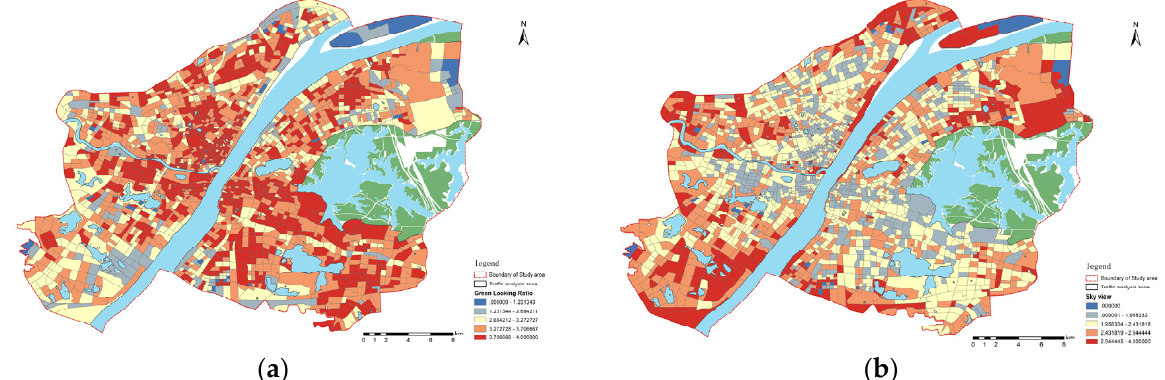
Figure 13. Block environment perception. ( a ) Green-looking ratio; ( b ) sky view. From the color distribution of the two graphs, it is clear that a block with a high green-looking ratio has a lower sky view, which aligns with the general perception. A high green-looking ratio implies dense greenery, which can block people’s view and decrease the percentage of visible sky. A small number of blocks have neither good greenery nor a density. The block within the Third Ring Road of Wuhan city has good performance